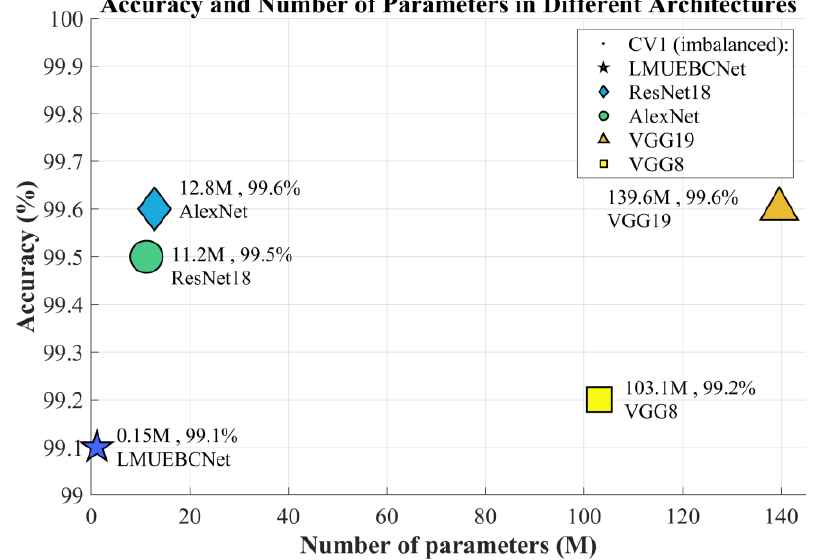
Figure 5. Total accuracy and the number of parameters in different CNN architectures.